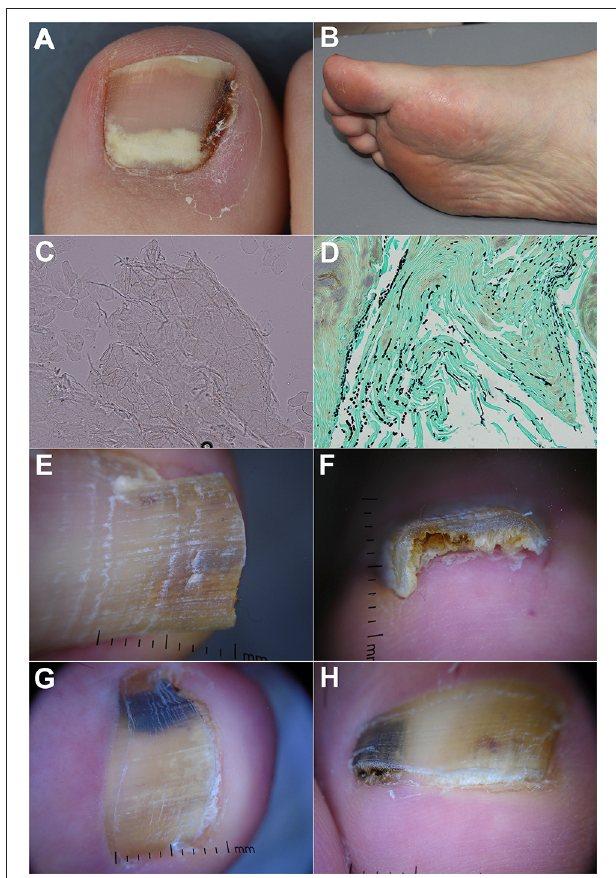
FIGURE 1 | (A) Proximal subungual onychomycosis in a patient with systemic lupus erythematosus. (B) Abnormal plantar desquamation increases the likelihood of clinically diagnosing onychomycosis. Thus, the sole should also be examined while assessing onychomycosis. (C) KOH-test highlighting presence of fungal hyphae ( × 200 magnification). (D) Histopathology (nail clipping) with GMS staining showing numerous fungal hyphae in the nail plate ( × 400). The fungi are highlighted in black with GMS staining. (E,F) Dermoscopic examination of onychomycosis showing yellowish discoloration with spikes pattern and surface scales. Distal edge dermoscopy demonstrating subungual hyperkeratosis. (G,H) Dermoscopic examination of fungal melanonychia showing reverse triangular pattern, yellow streaks, black and yellow coloration, scales, and subungual hyperkeratosis.